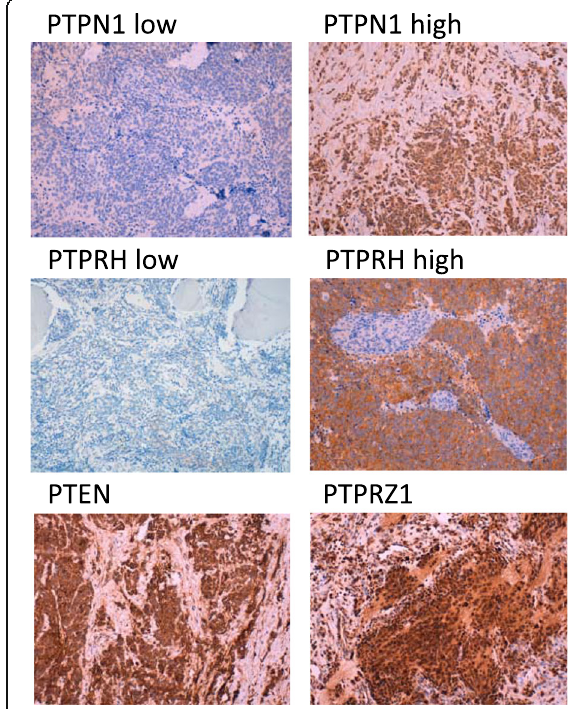
Fig. 3 Immunostaining of PTPs from NB tissue sections. Representative PTPN1, PTPRH, PTPRZ1, and PTEN immunostaining patterns are shown. In the case of PTPN1 and PTPRH, selected images of low and high immunoreactivity are shown (magnification: